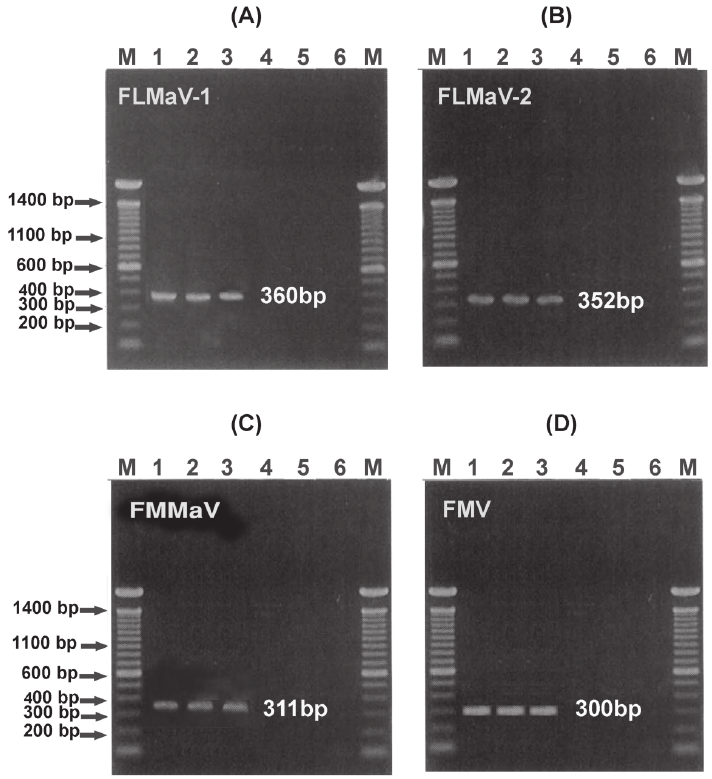
Figure 2. Electropherogram of polyacrylamide gel showing PCR ampli fi cations from infected fi gs. (A) FLMaV-1, ( B) FLMaV-2, (C) FMMaV and (D) FMV. Lane M, DNA ladder marker, Lanes 1, 2 and 3 represent PCR-positive infected fi g plants. Lanes 4 and 5 represent healthy fi